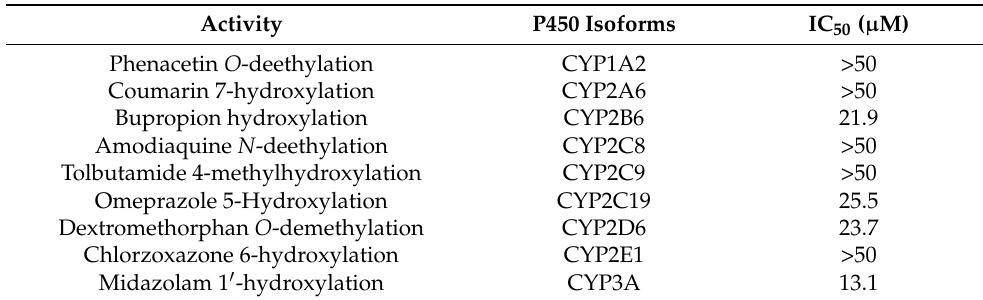
Table 2. Inhibitory potential of seongsanamide A against the activities of nine cytochrome P450 isoforms in human liver